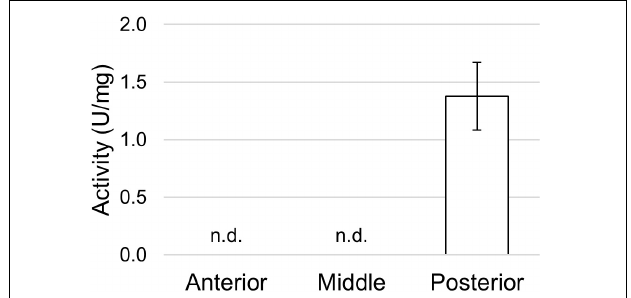
FIGURE 11 | Aminopeptidase N activity in the different midgut regions using L-leucine p-nitroanilide as substrate. The values are reported as mean ± SEM of at least 3 experiments. In the anterior and middle midgut no activity was detected